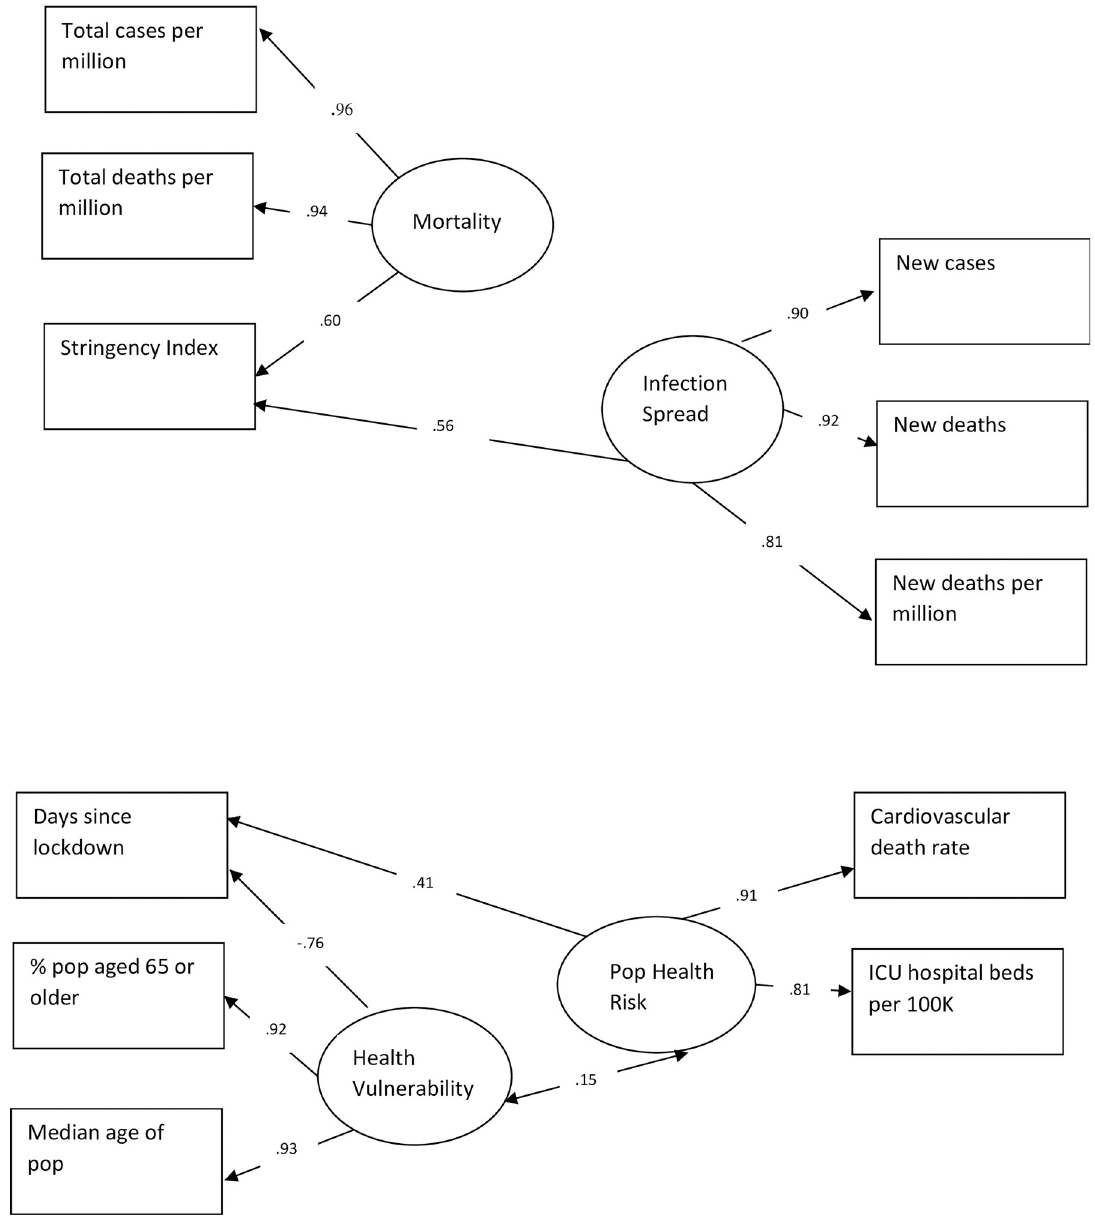
Fig 3. Latent variable path analysis of covid-19 impact using Maximum Likelihood (ML) estimation. (Comparative Fit Index = 0.91; Tucker-Lewis Index = 0.85; Standardized Root Mean Square Residual = 0.08.